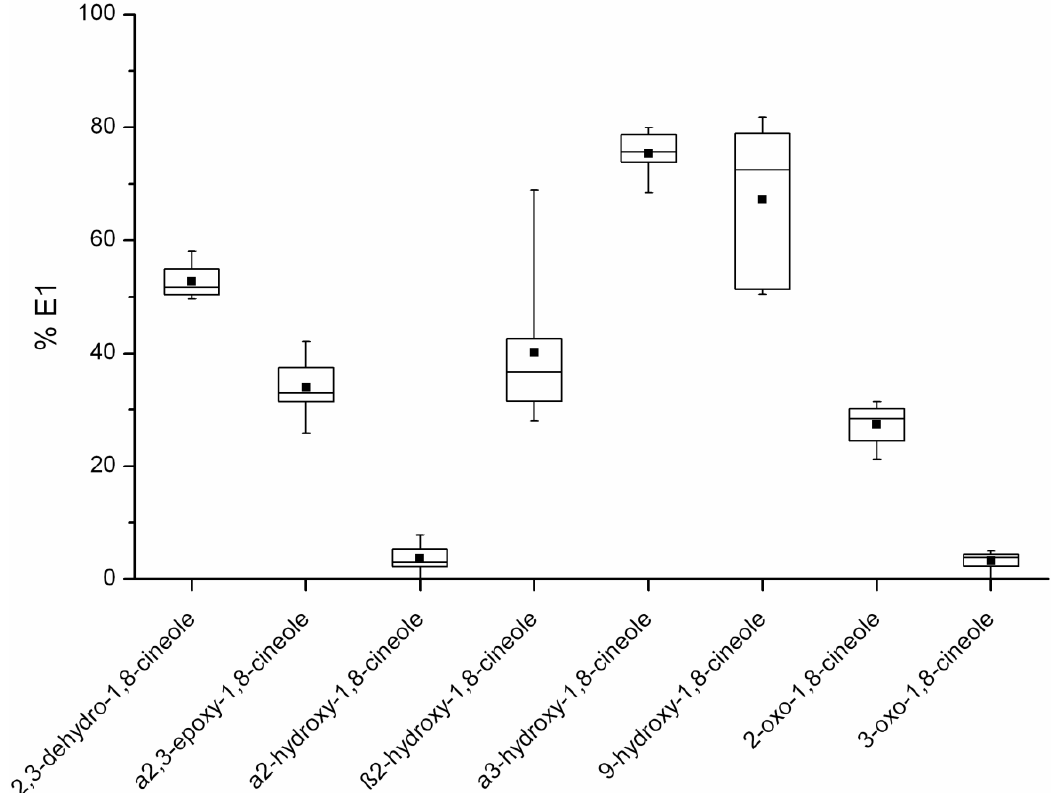
Figure 5. Boxplot of the percentage of enantiomer E1 for the chiral metabolites of 1,8-cineole detected in human milk